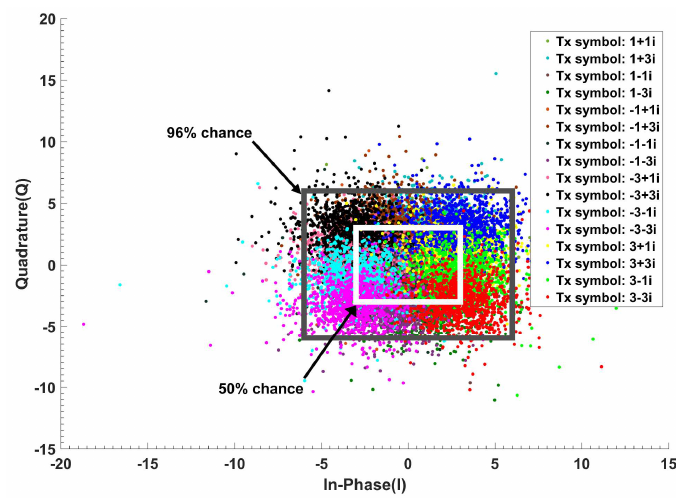
Figure 9. Received symbols ( Y k n ) after linear equalization from the simulation results. Figure 9. Received symbols ( 𝑌 (cid:3041)(cid:3038) ) after linear equalization from the simulation results. Figure 9. Received symbols ( 𝑌 (cid:3041)(cid:3038) ) after linear equalization from the simulation results.